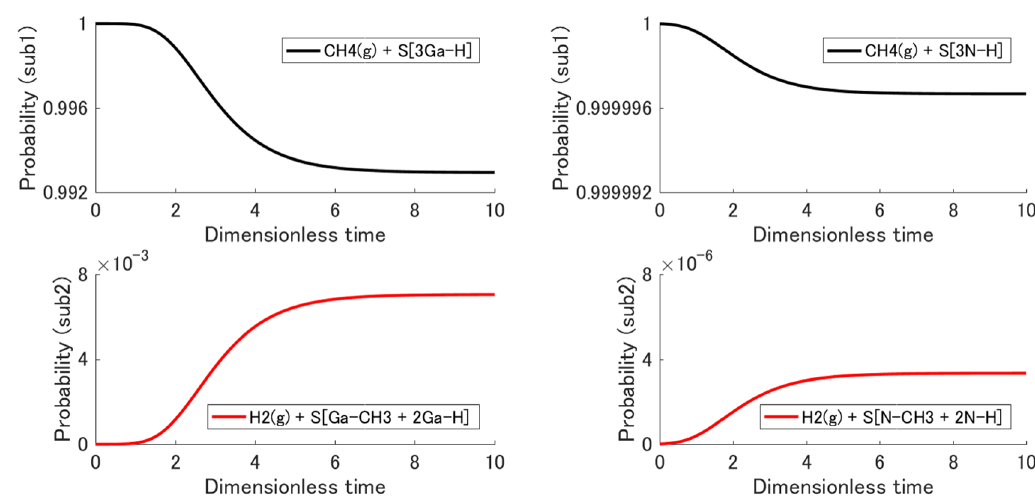
Figure 5. Evolution of the total probability of each subsystem for the adsorption reaction in (0001) and (000−1); that of subsystem 2 corresponds to the adsorption probability of CH 4 .